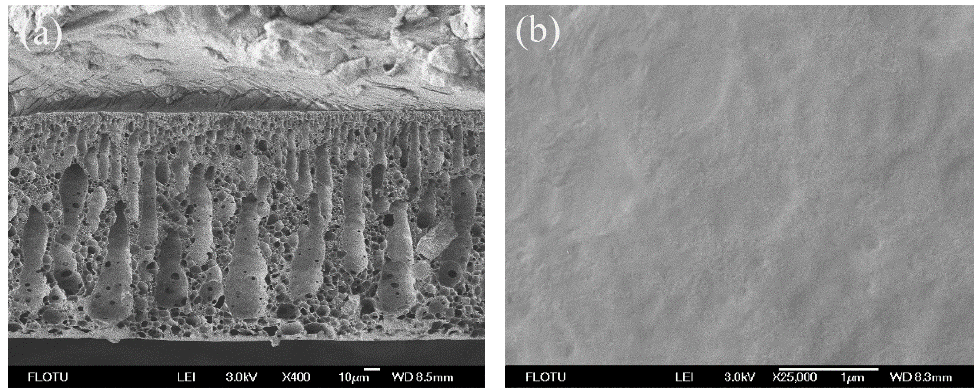
Figure 2. SEM photomicrographs of neat PPSU membranes: ( a ) cross-section; ( b ) top surface.